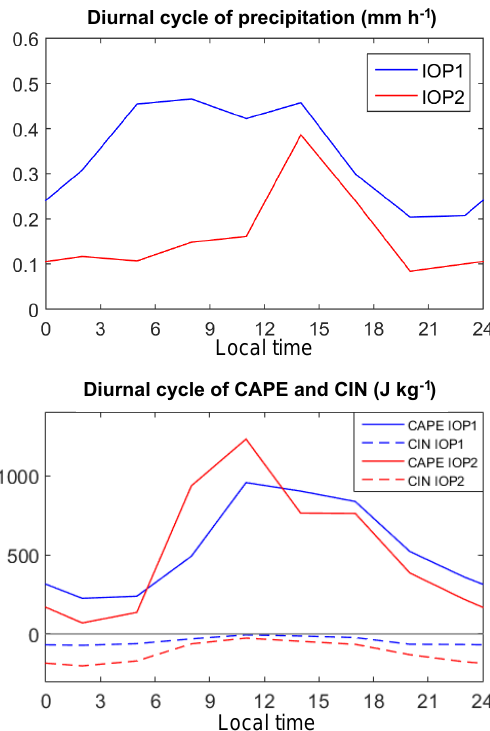
Figure 7. The diurnal cycle of precipitation (up) and CAPE and CIN (bottom) for both